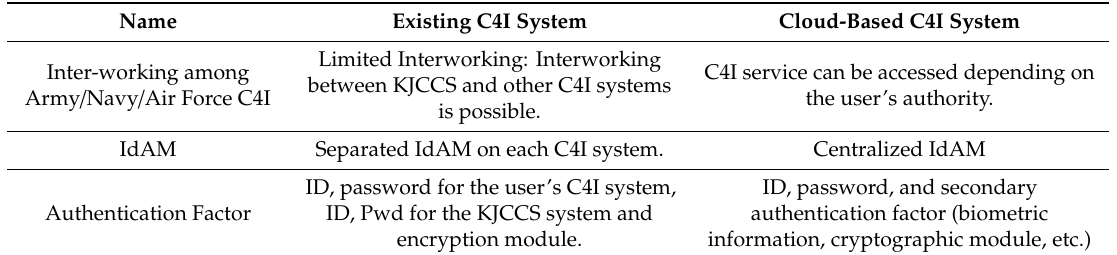
Table 5. Comparison between Existing C4I System and Cloud-based C4I